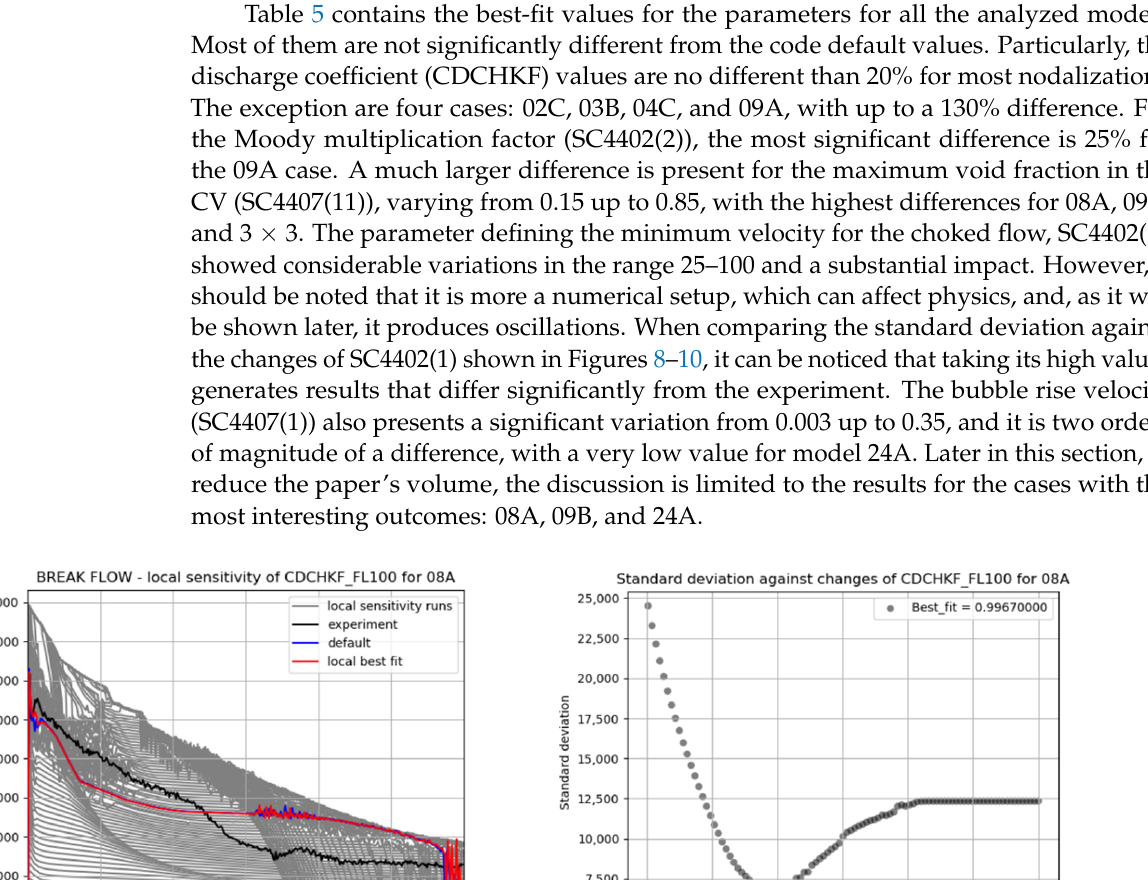
Table 5. “Best-fit” parameter values for the different